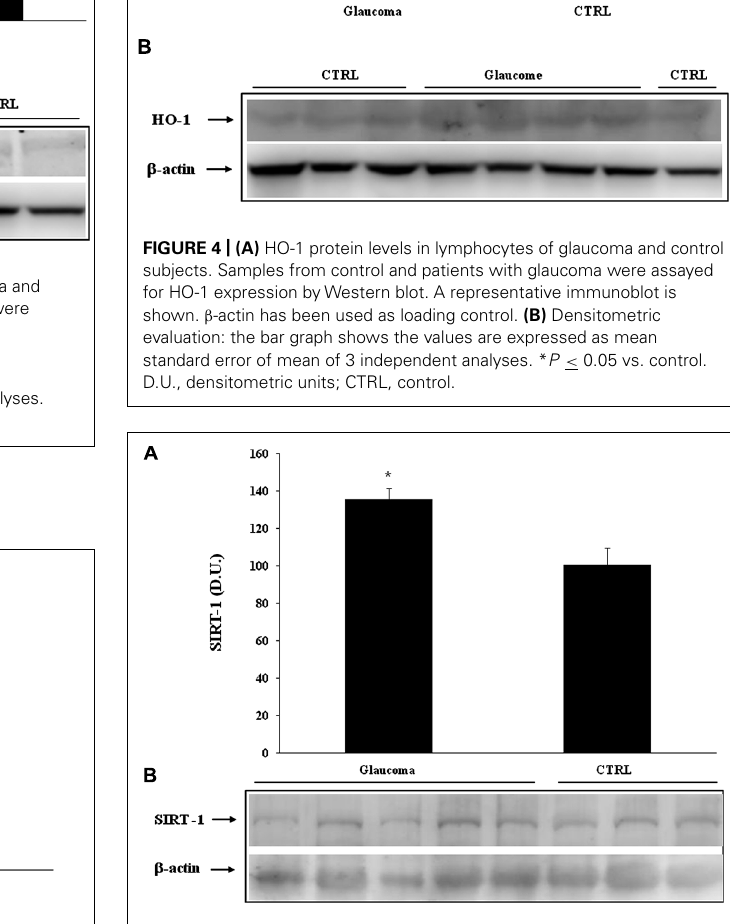
FIGURE 5 | (A) Sirtuin-1 protein levels in plasma of glaucoma and control subjects. Samples from control and patients with glaucoma were assayed for Sirt-1 expression byWestern blot. A representative immunoblot is shown. β -actin has been used as loading control. (B) Densitometric evaluation: the bar graph shows the values are expressed as mean standard error of mean of three independent analyses. * P < 0.05 vs. control. D.U., densitometric units; CTRL,